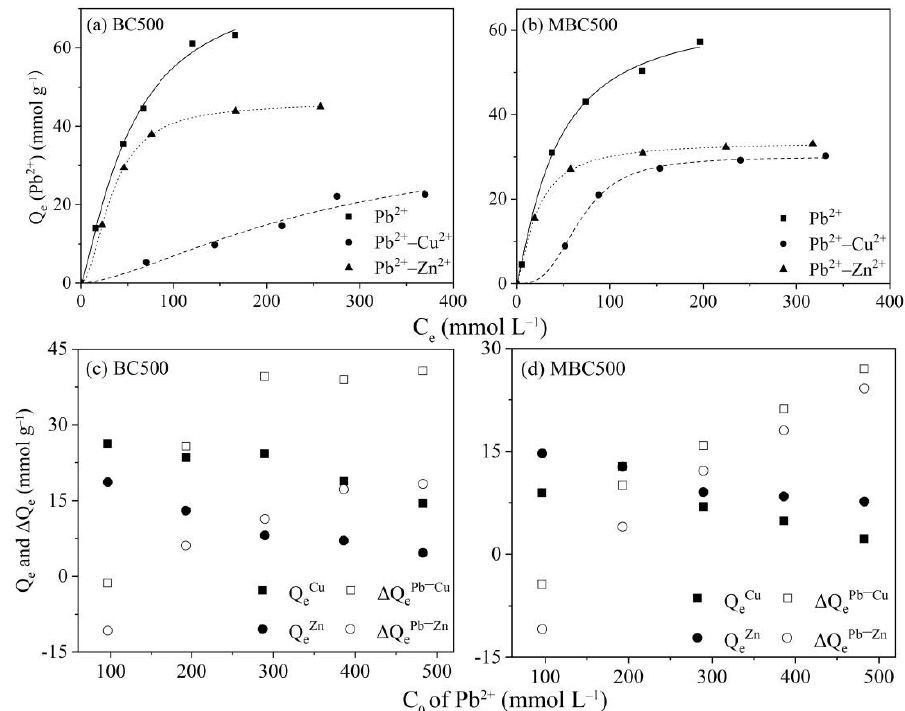
Figure 2. Effect of Cu 2+ /Zn 2+ on adsorption capacity of Pb 2+ on BC500 ( a , c ) and MBC500 ( b , d ) (Q eCu and Q eZn represent the adsorption capacities of Cu 2+ and Zn 2+ in the binary metal system; ∆ Q ePb − Cu and ∆ Q ePb − Zn represent the ∆ Q e of Pb 2+ in Pb 2+ –Cu 2+ and Pb 2+ –Zn 2+ competitive sys- tems).